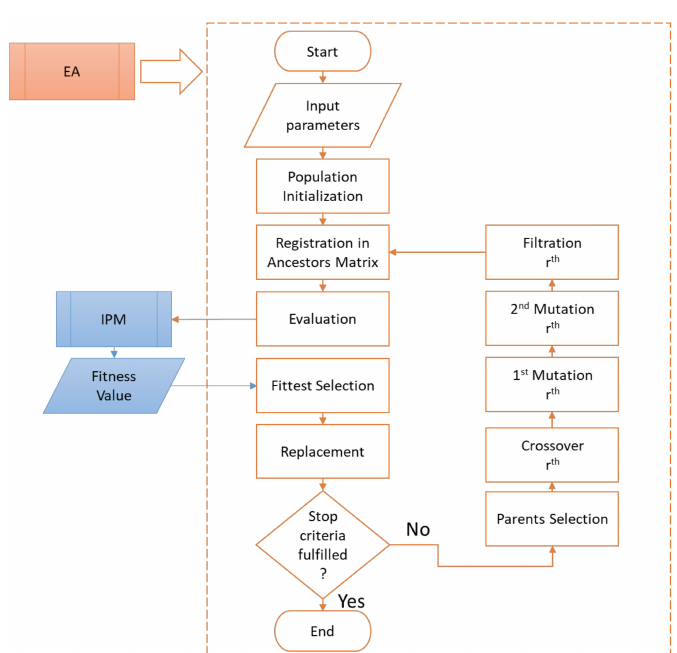
Figure 13. Proposed evolutionary algorithm flow